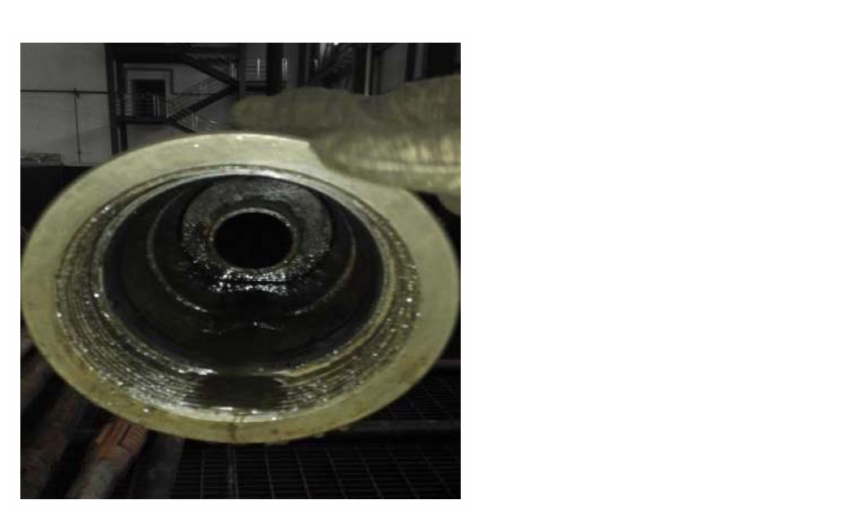
Figure 17. After the experiment, the rubber packing element was still firmly set on the